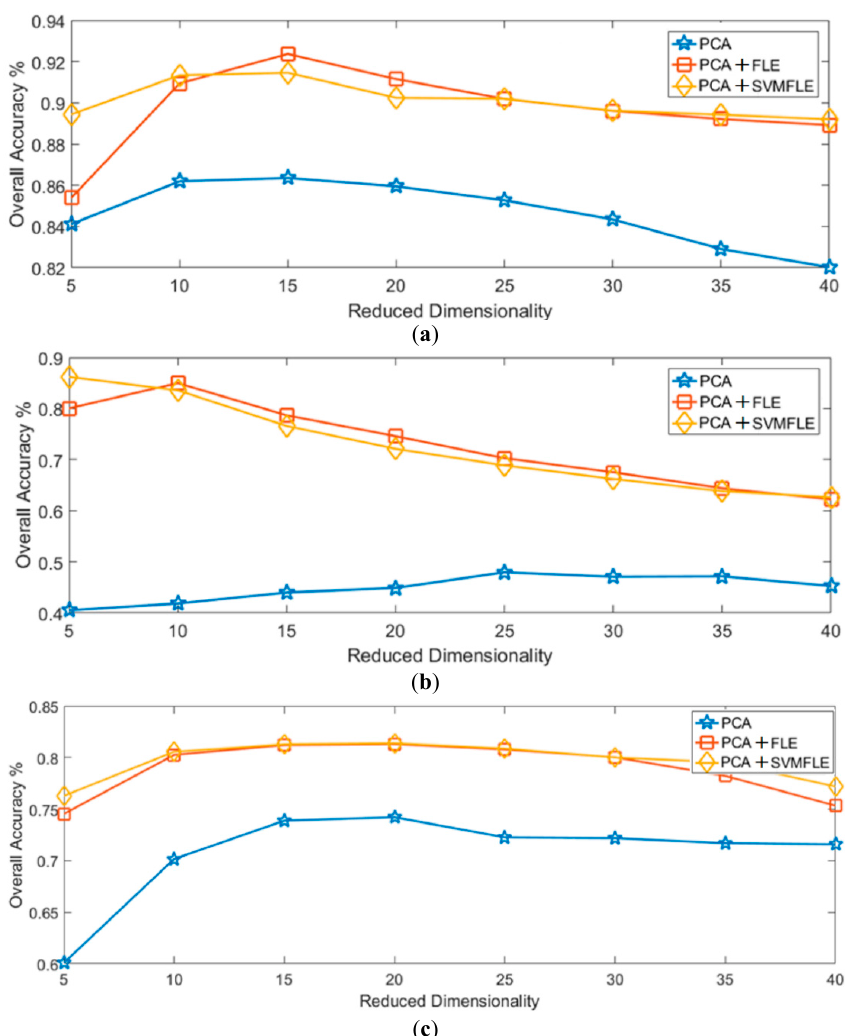
Figure 12. The reduced dimension versus the classification accuracy by NN classifier on three datasets: ( a ) Salinas; ( b ) Pavia University; ( c ) IPS.